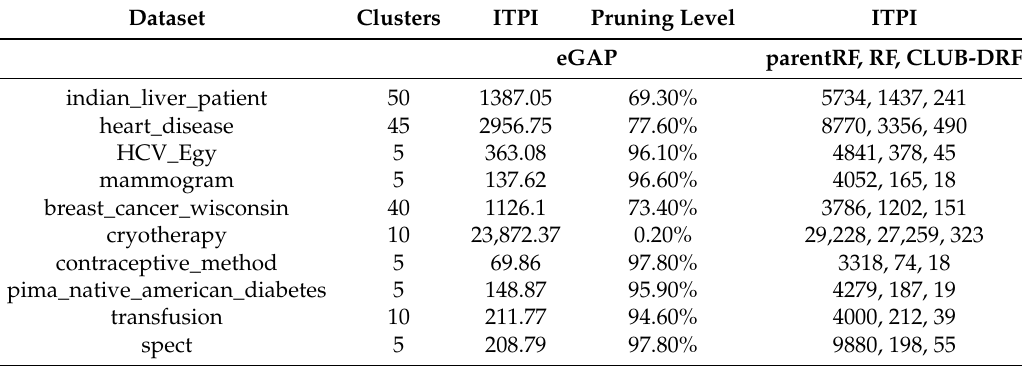
Table 6. Inference Time per Instance (ITPI) and pruning level performance metrics of eGAP vs. parentRF, RF, and CLUB-DRF on classification